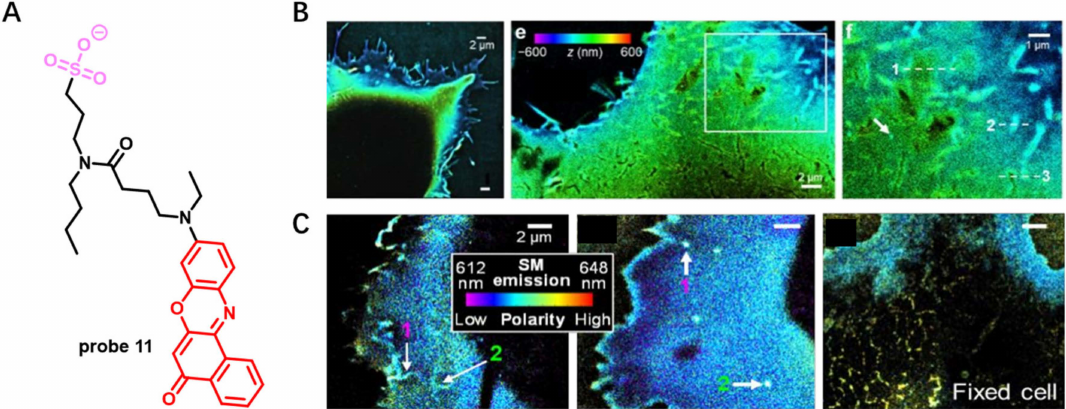
Figure 10. ( A ) Chemical structure of probe 11 . ( B ) 3D PAINT image of COS-7 cells with probe 11 . ( C ) SR-PAINT with probe 11 for CM in live and fixed COS-7 cells. Scale bar: 2 µ m. Copyright 2019 John Wiley and Sons [66].